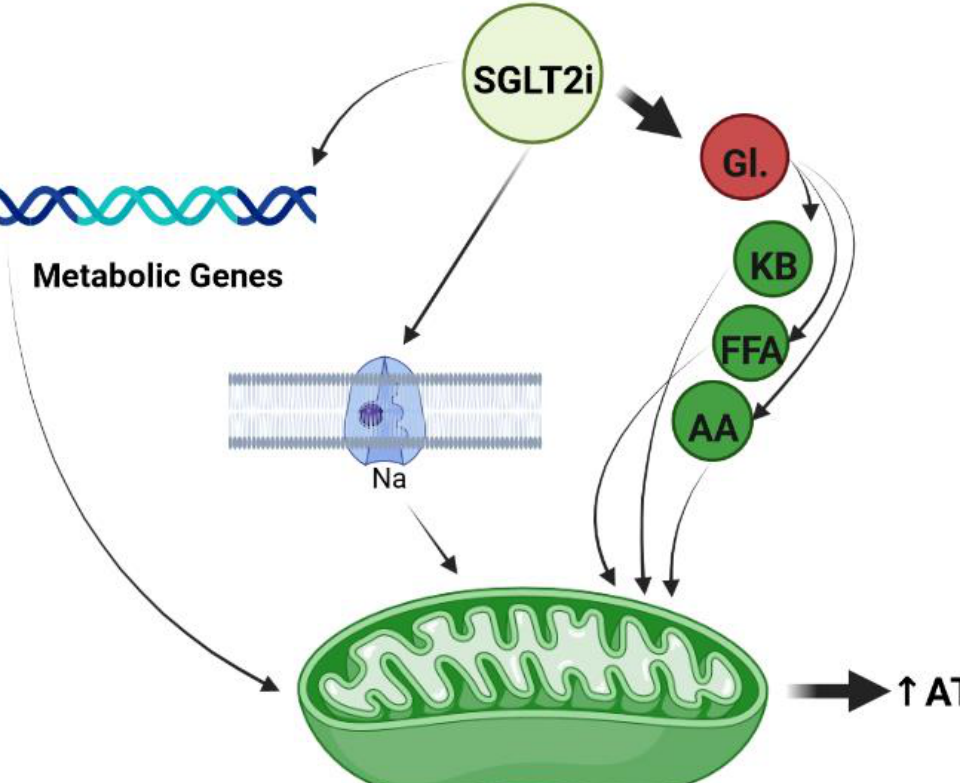
Figure 3: SGLT2 inhibition improves mitochondrial metabolism via 1. Switching fuel utilization from Gl. (glucose) to KB (ketone body), FFA (free fatty acid) and AA (amino acid), 2. Upregulation of metabolic genes, and 3. Increase in voltage-gated sodium currents in